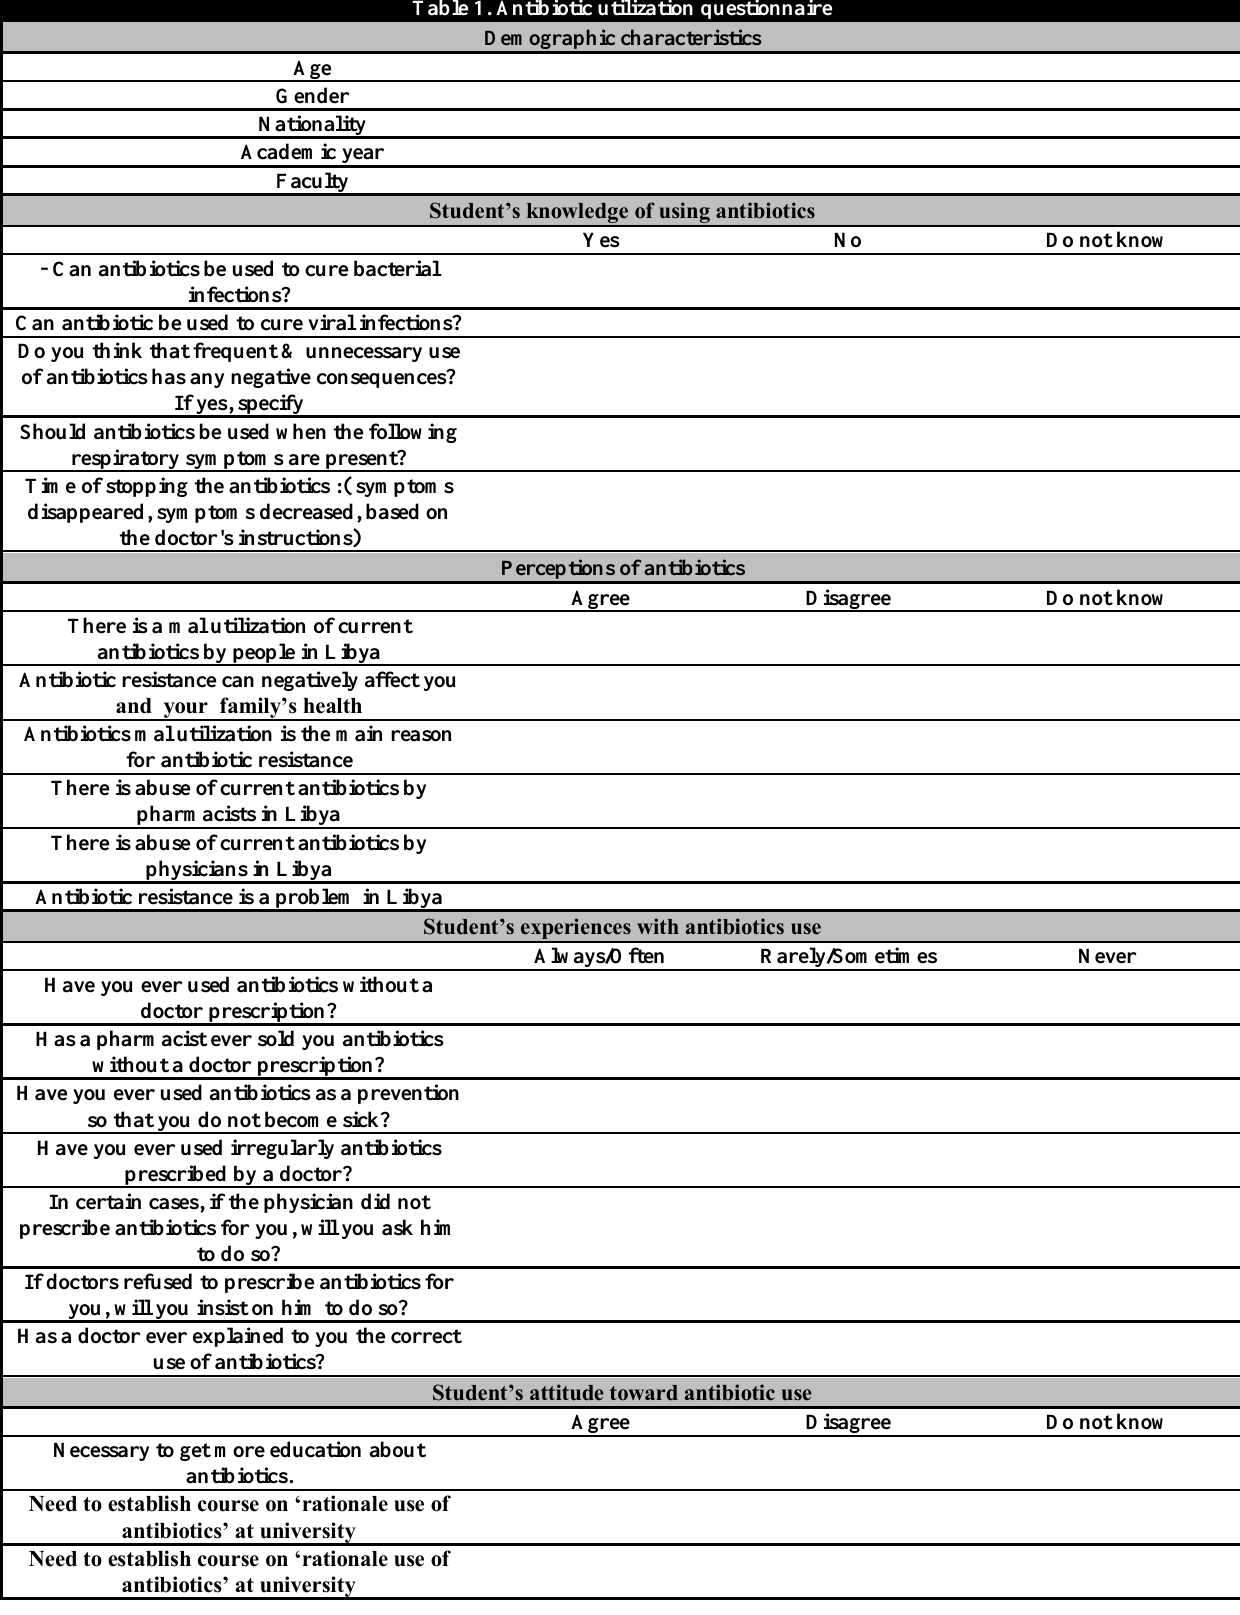
Table 1. Antibiotic utilization